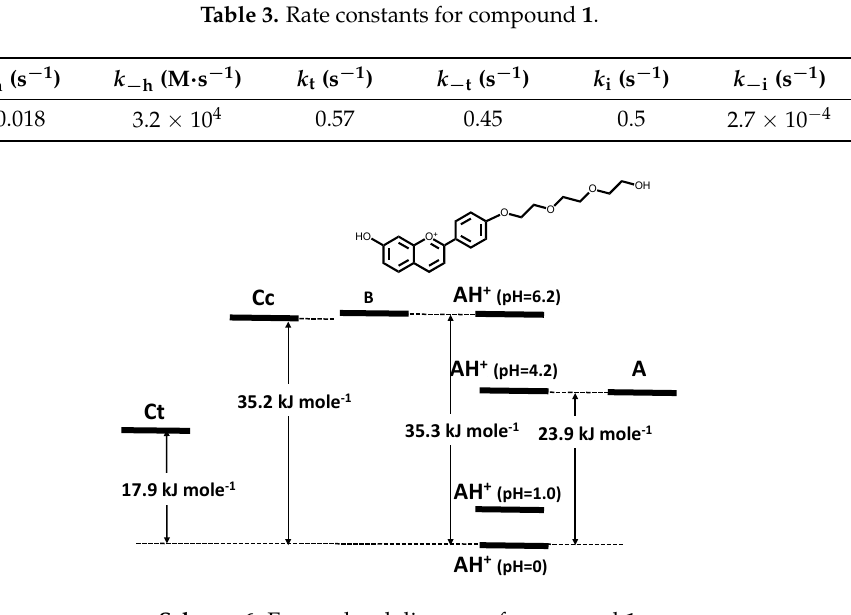
Scheme 6. Energy level diagram of compound 1 .